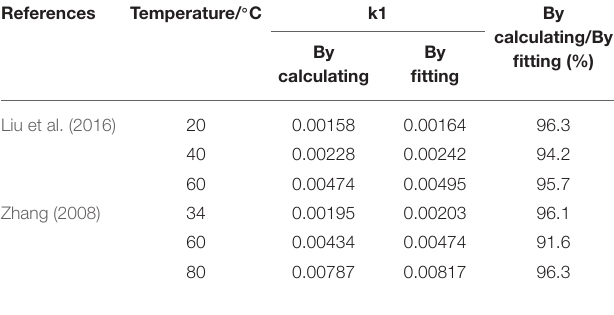
TABLE 4 | The tensile strength degradation rate ( k 1 ).